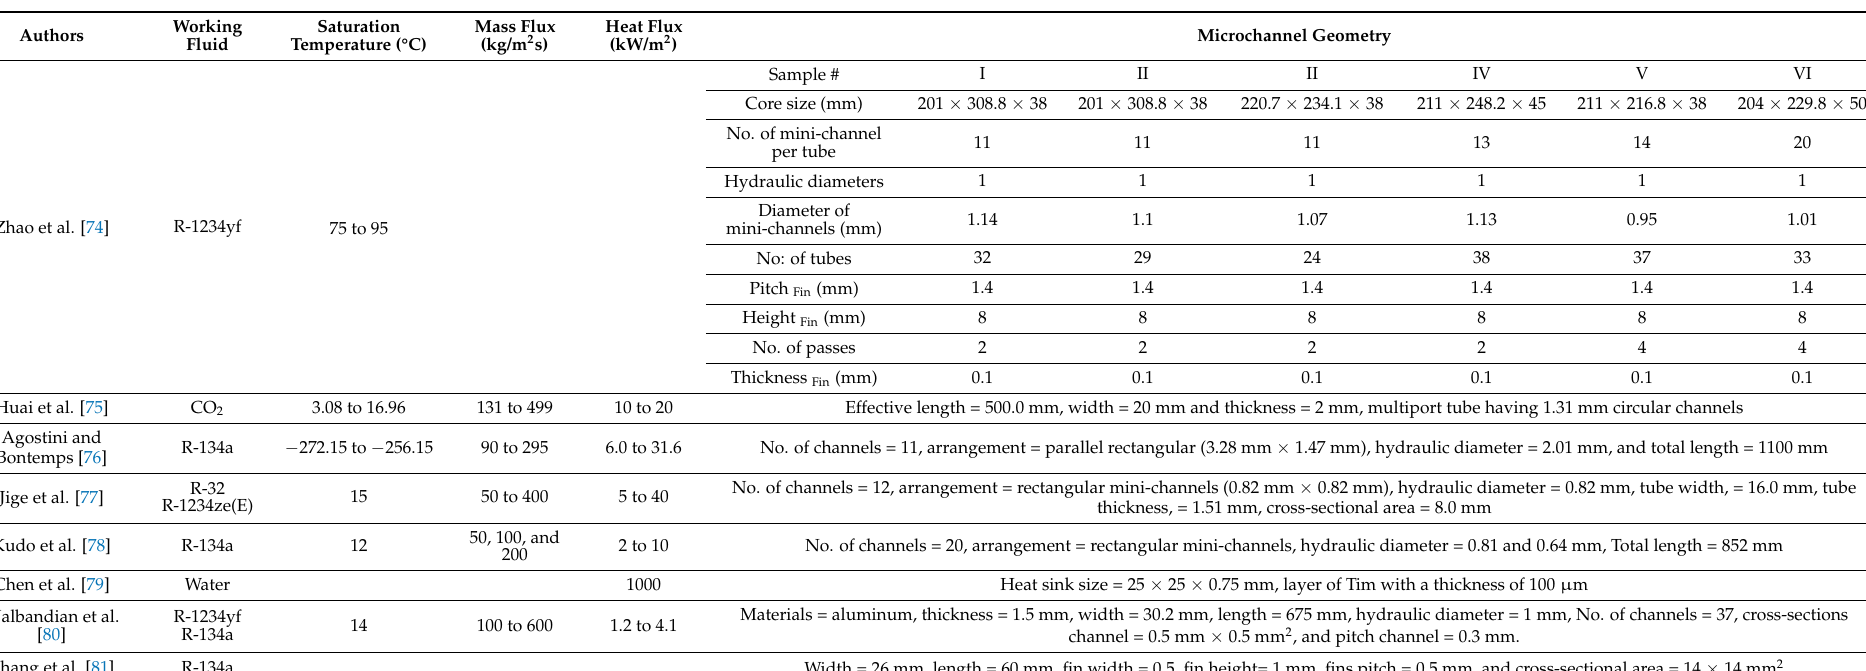
Table 4. Experimental conditions, specifications and dimensions of the microchannel as reported in the